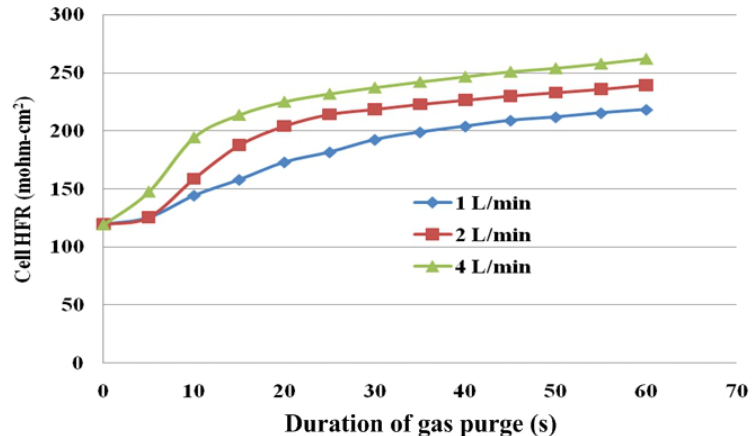
Figure 10. Overall variation of HFR in cell with flow rate of purging